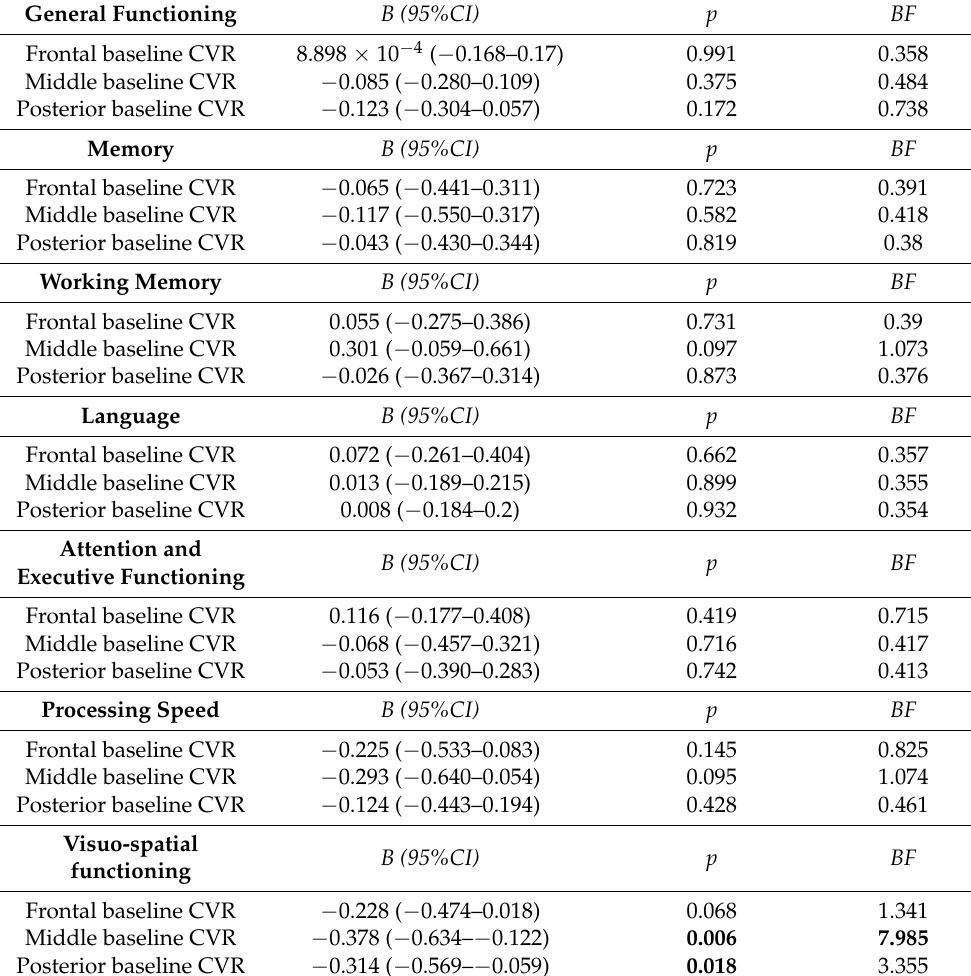
Table A3. Baseline CVR versus change in cognitive domains (univariable linear regression and Bayesian